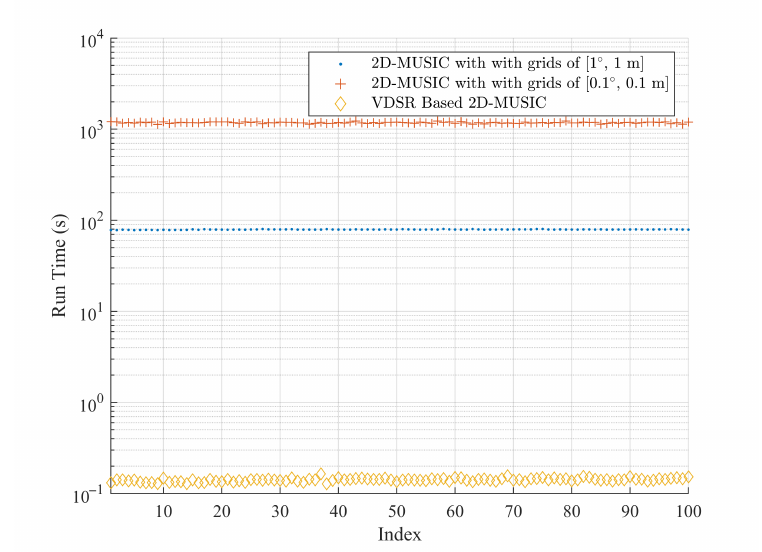
Figure 8. Simulation runtime.